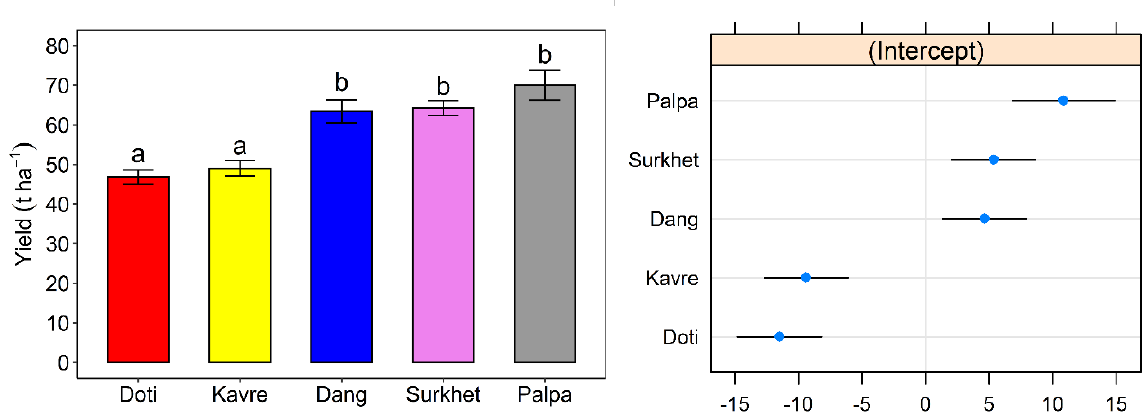
Figure 3. Effect of location (districts) on tomato yield following the mixed effect model ( n = 28). Different letters inside a bar represent significant differences in tomato yield across the district lo- cations.